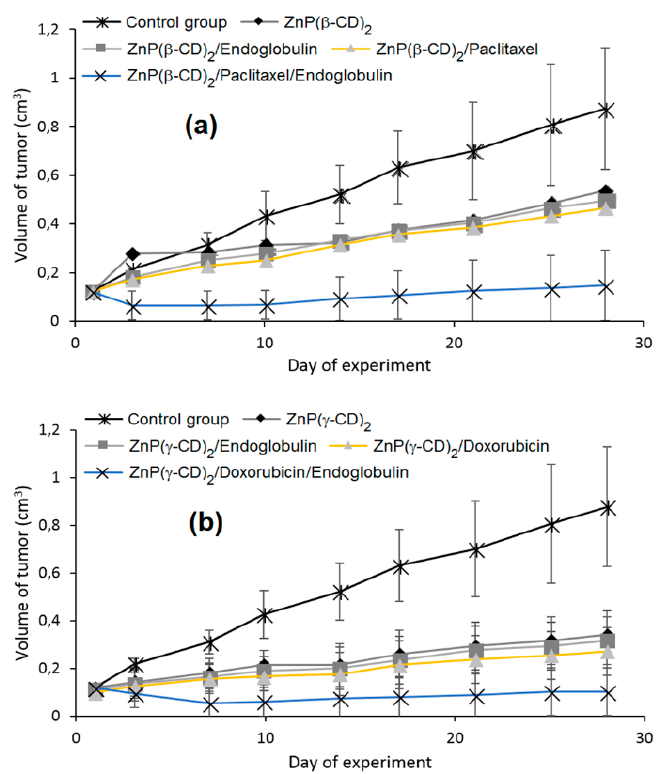
Figure 22. Effect of combined therapy with ZnP( β -CD) 2 or ZnP( γ -CD) 2 conjugates, chemotherapy drugs (paclitaxel or doxorubicin), and endoglobulin on the tumor volume of human amelanotic melanoma C32 in an in vivo nude mouse model. ( a ) ZnP( β -CD) 2 /paclitaxel/endoglobulin or ( b ) ZnP( γ -CD) 2 /doxorubicin/endoglobulin ( n = 6 at each group). Adapted from Kejik; Briza; Kralova; Pouckova; Kral; Martasek; Kral [141].